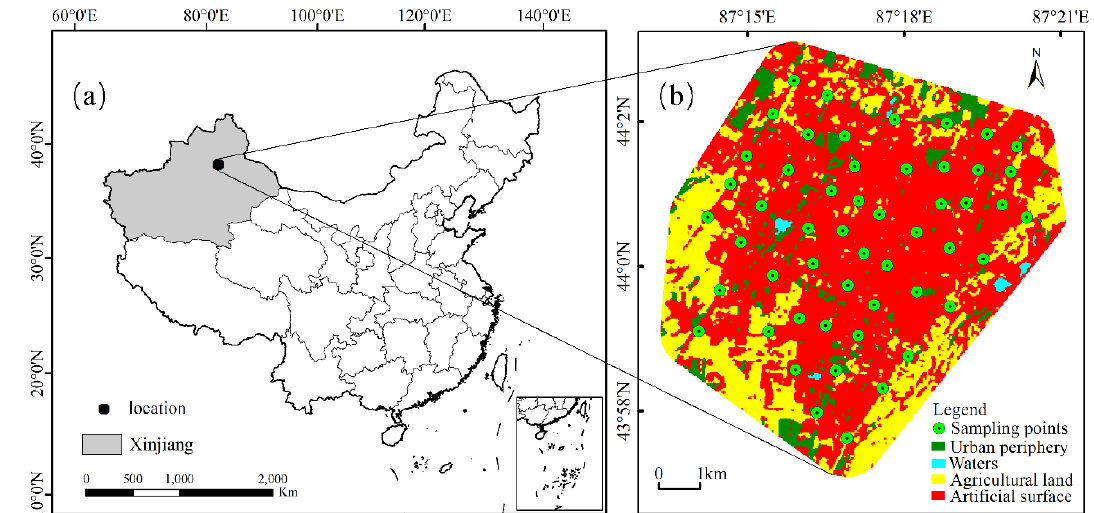
Figure 1. A map of the study area and sampling points. ( a ) Location of Xinjiang in China; ( b ) spatial distribution map of sampling sites in Changji City.